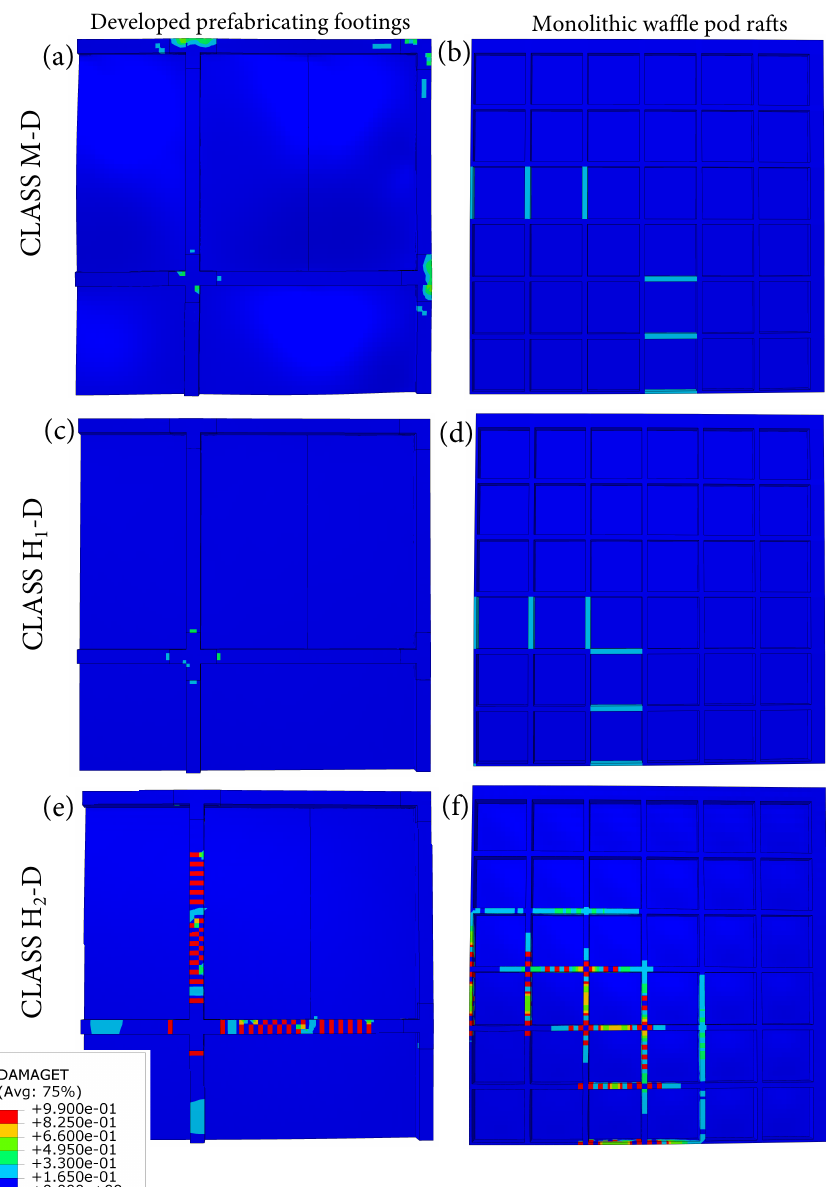
Figure A3. Comparison of footing damage due to swelling soil between the developed prefabricated footing systems and waffle rafts for ( a , b ) Class M-D soil, ( c , d ) Class H 1 -D soil, and ( e , f ) Class H 2 -D soil. A value of DAMAGET ( d t ) greater than zero reflects concrete cracking, classified as: DAMAGET ( d t ) < 0.25 = hairline cracks, 0.25 ≤ DAMAGET ( d t ) < 0.85 = fine but noticeable cracks, 0.85 ≤ DAMAGET ( d t ) < 0.99 = distinct cracks, and DAMAGET ( d t ) ≥ 0.99 = wide cracks or gaps